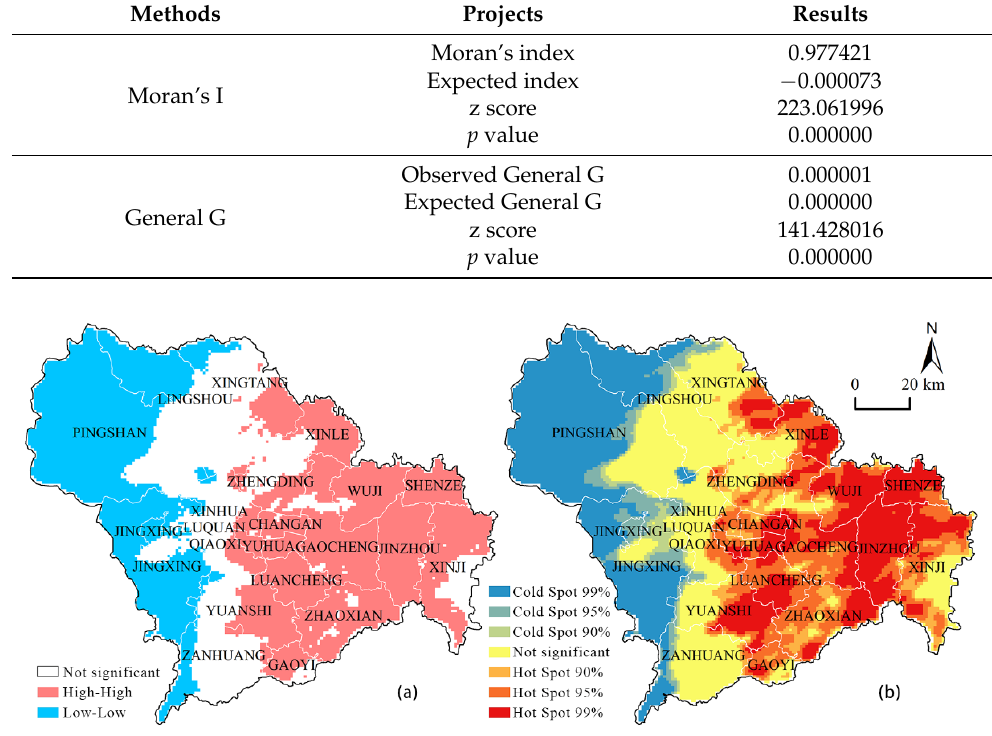
Figure 5. Clustering and hotspot analysis results: ( a ) Anselin local Moran results; ( b ) Getis–Ord-Gi* results.